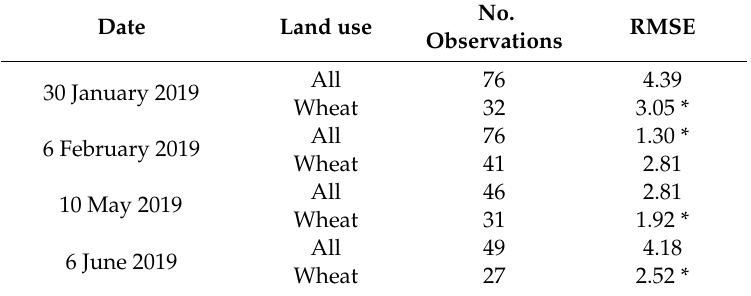
Table 7. Statistics of regression kriging using leave-one-out cross-validation to calculate the root mean square error.